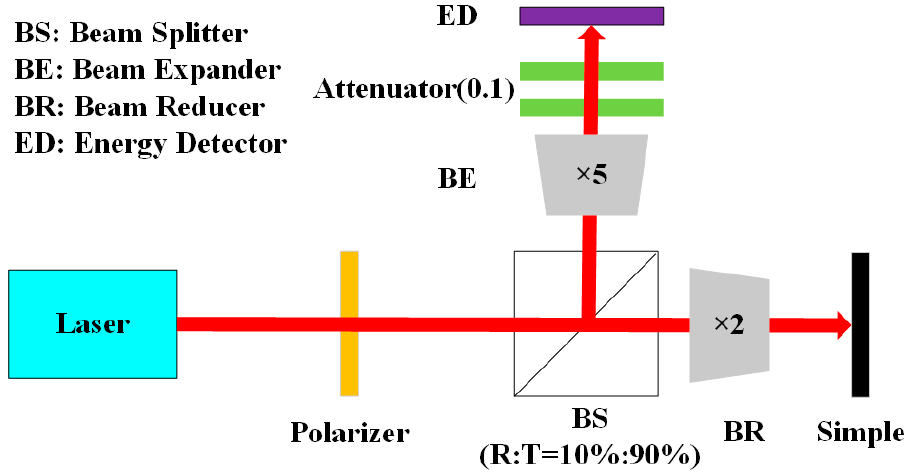
Figure 1. The diagram of the sample preparation system.